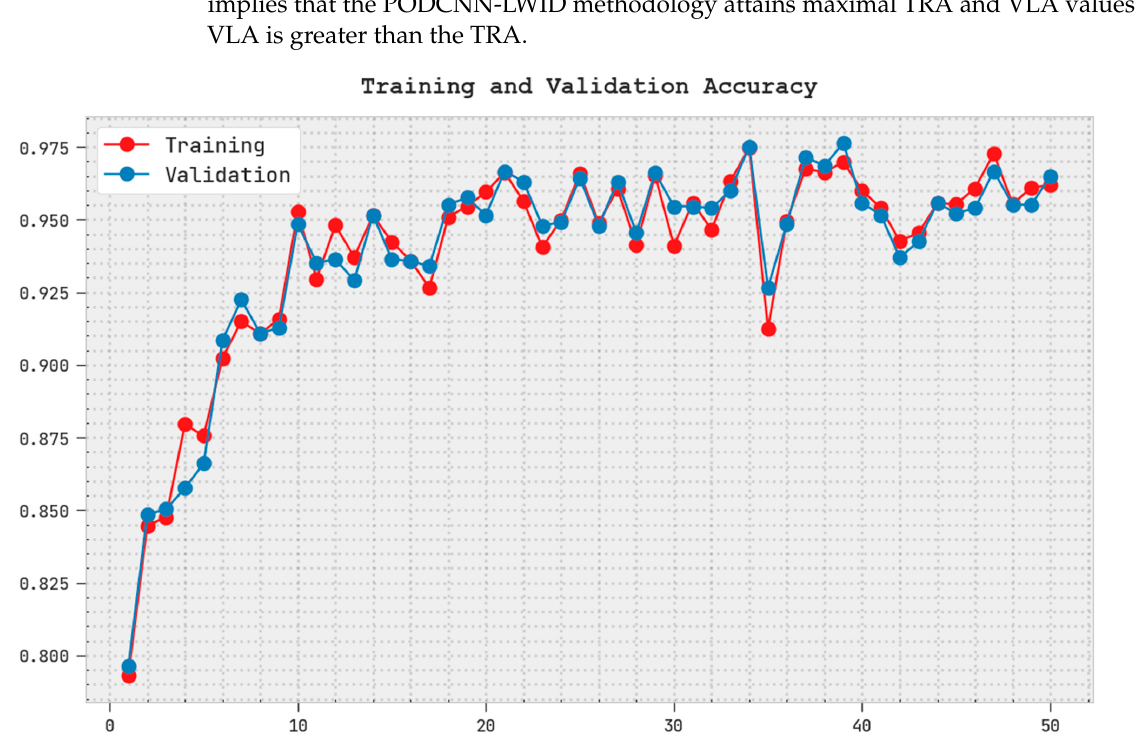
Figure 6. TRA and VLA analysis of PODCNN-LWID approach. The training loss (TRL) and validation loss (VLL) obtained by the PODCNN-LWID algorithm with the test dataset are displayed in Figure 7. The experimental outcome indi- cates that the PODCNN-LWID method exhibits minimal TRL and VLL values. In partic- ular, the VLL is less than the TRL.